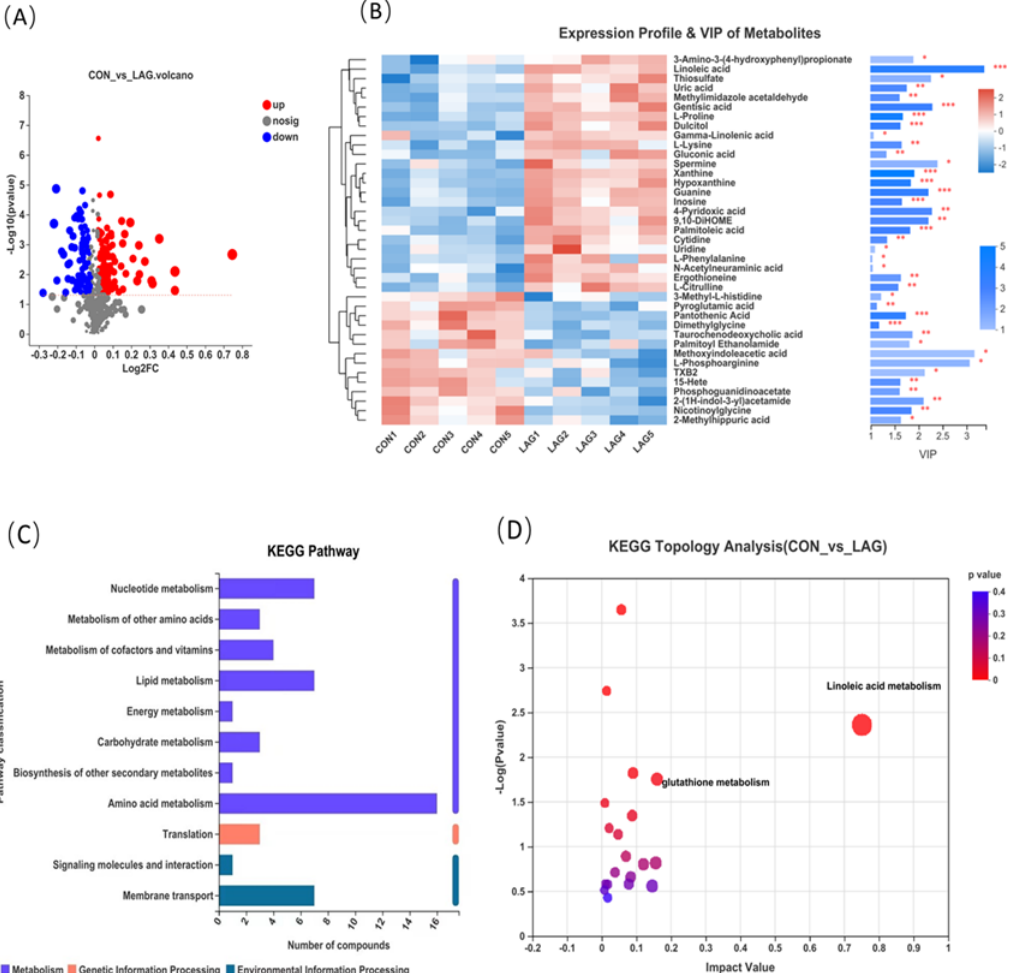
Figure 5. ( A ) Differential volcano plot of CON and LAG groups, each point in the graph represents a specific metabolite and larger points indicate higher VIP values. Blue indicates significant downregu- lation and red indicates significant upregulation. ( B ) Heatmap combined with hierarchical clustering of the most significantly influenced metabolites in CON and LAG groups. Only the metabolites with the highest variable importance in projection (VIP) value in the OPLS-DA model (top 40 named metabolites) were listed. The t -test was jointly applied with the OPLS-DA to identify the discrepant metabolites and the p value in the t -test was shown. The heatmap colors represent the relative expression of metabolites in the sample, with VIP bar graphs of metabolites on the right. The bars’ length represents the metabolites’ contribution value to the difference between the two groups. The larger the value, the more significant the difference between the two groups. The bar’s color indicates the significance of the metabolite difference between the two groups (* 0.01 < p ≤ 0.05, ** 0.001 < p ≤ 0.01, *** p ≤ 0.001). ( C ) KEGG pathway, the ordinate, is the second classification of the KEGG metabolic pathway and the abscissa is the number of metabolites annotated to the pathway. ( D ) KEGG topology analysis. Each bubble in the figure represents a KEGG Pathway; the horizontal axis represents the relative importance of the metabolites in the pathway and the size of the Impact Value; importance